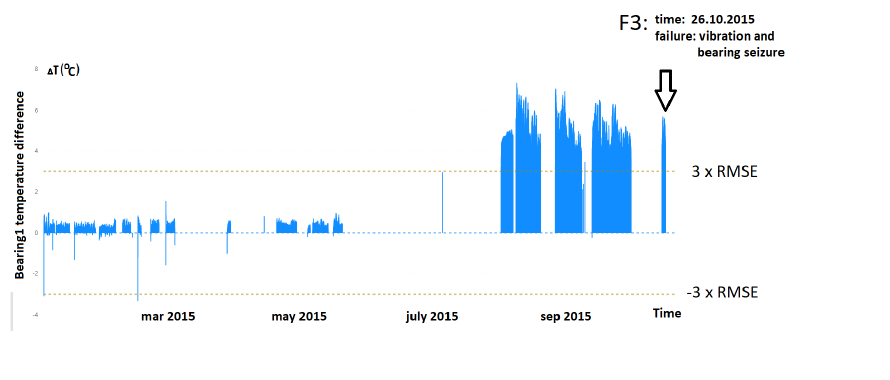
Figure 8. Difference between the real and estimated value of temperature of Bearing